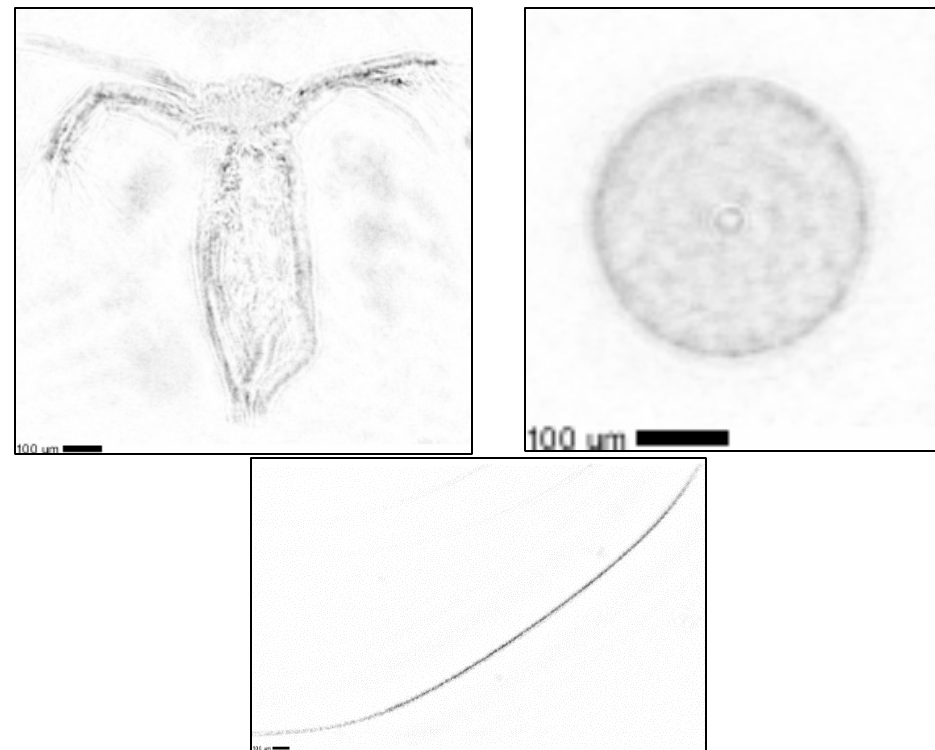
Figure 7. Samples of particles detected by LISST-HOLO2.